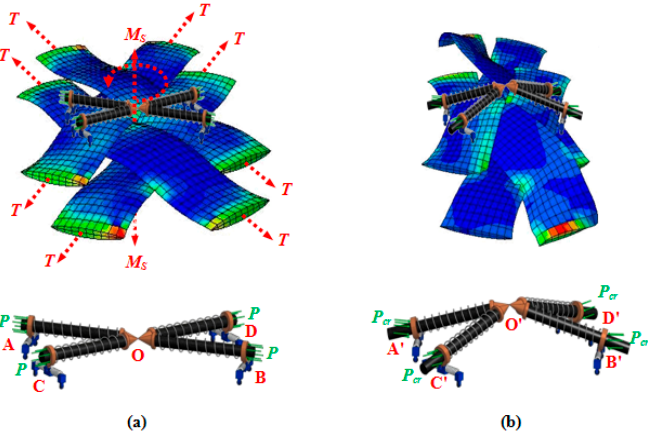
Figure 7. Equivalent structure ( a ) before equilibrium deviation; ( b ) after equilibrium deviation.